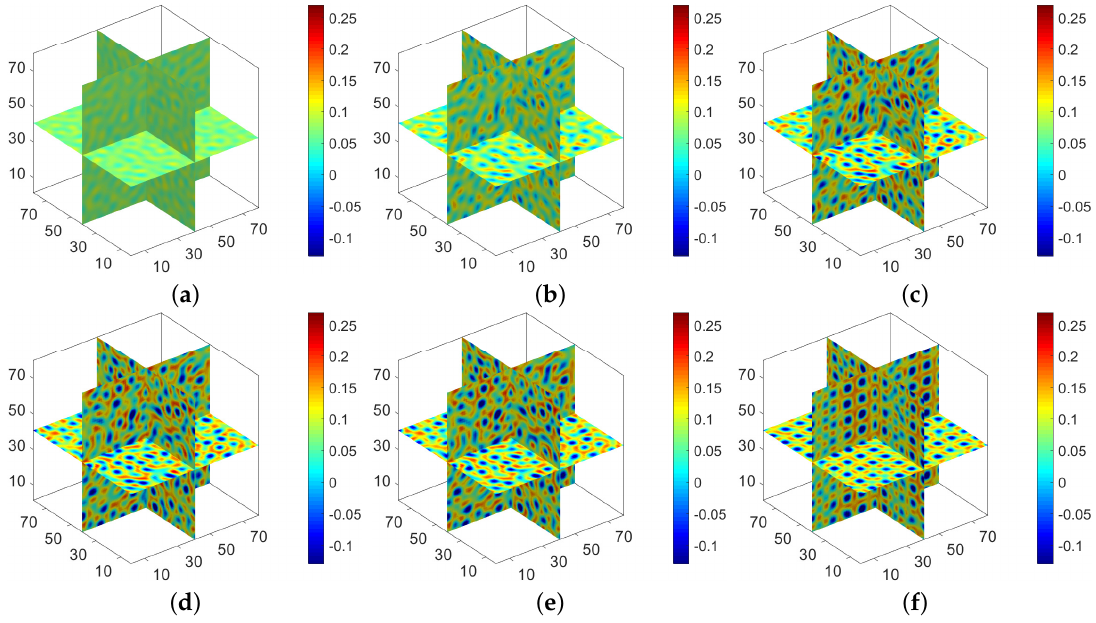
Figure 35. Temporal evolutions of the SH equation with the initial condition (88) using the Fourier-spectral method. ( a – f ) are snapshots at t = 150, 300, 450, 600, 900, and 1500, respectively.